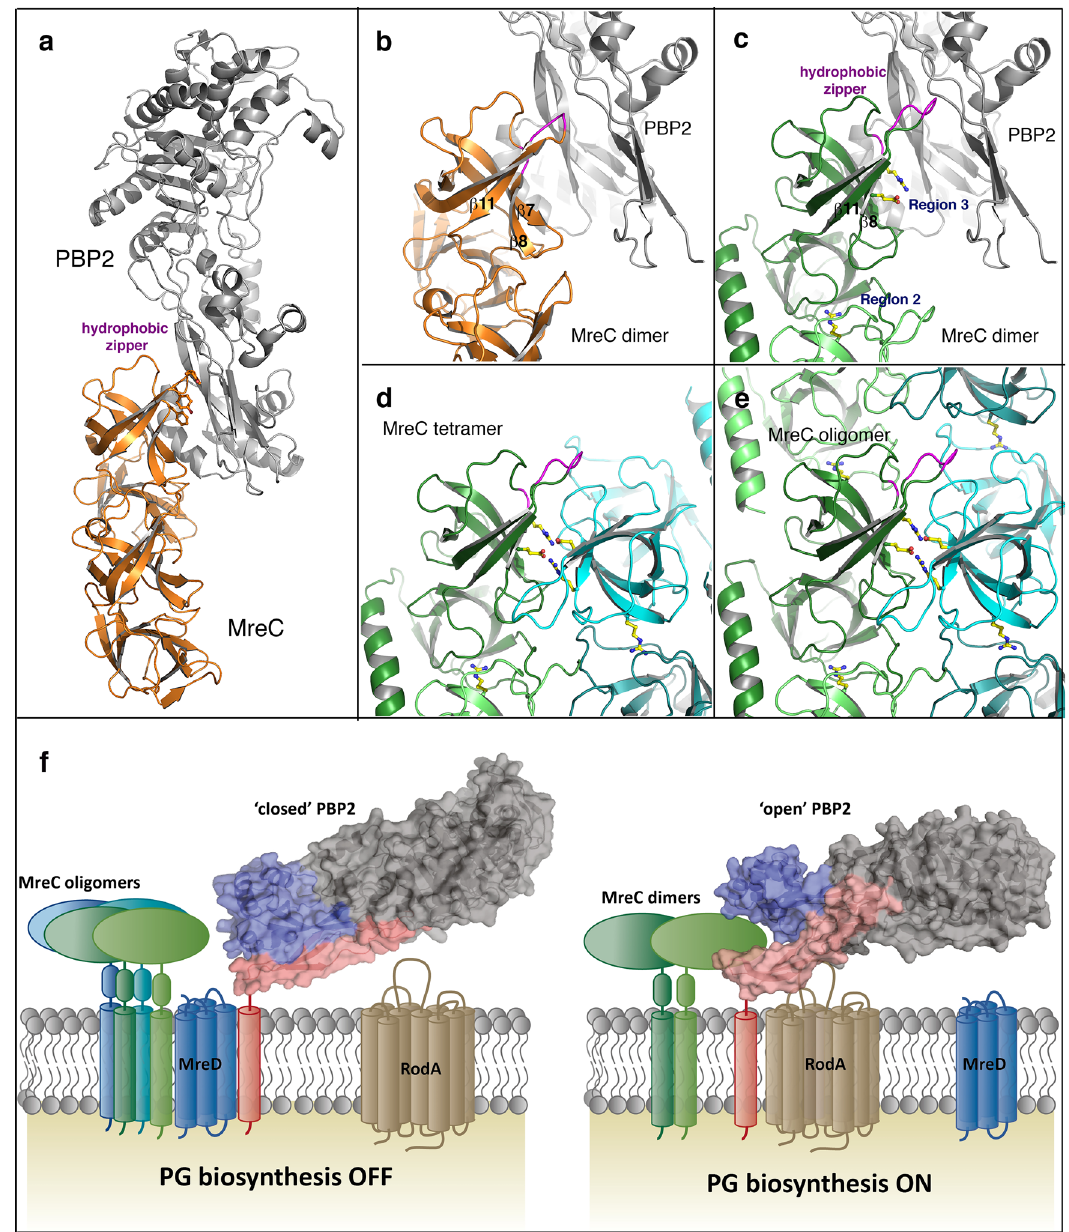
Fig. 4 MreC modulates PG formation during cell wall elongation by self-association. a Crystal structure of the MreC:PBP2 complex from H. pylori (PDB 5LP5). b closeup of the MreC:PBP2 interaction region, with the hydrophobic zipper region of MreC highlighted in magenta. MreC Hp is in orange, PBP2 in gray. c overlay of the MreC Pa dimer (green) onto MreC Hp within the MreC:PBP2 structure reveals that the potential hydrophobic zipper of MreC Pa is in close proximity to Region 3 (Glu188, Arg190). In this situation, MreC ’ s self-association capacity is blocked by the presence of PBP2. d , e in the absence of PBP2, Region 3 is free and MreC dimers associate into stable tetrameric forms, giving rise to higher-order structures that do not interact with PBP2. Arg175 (Region 2) is essential for interactions both in the presence and absence of PBP2. f Schematic model of MreC ’ s modulation of cell wall elongation. PBP2 is shown in gray, pink (anchor) and blue (head). MreC oligomers and PBP2, both contacted by MreD 23 , do not interact and PG biosynthesis is off. A signal, which could involve accumulation of MreC beyond a given threshold, displaces MreD and allows MreC to interact with an open form of PBP2, which in turn recognizes RodA and activates PG biosynthesis 22